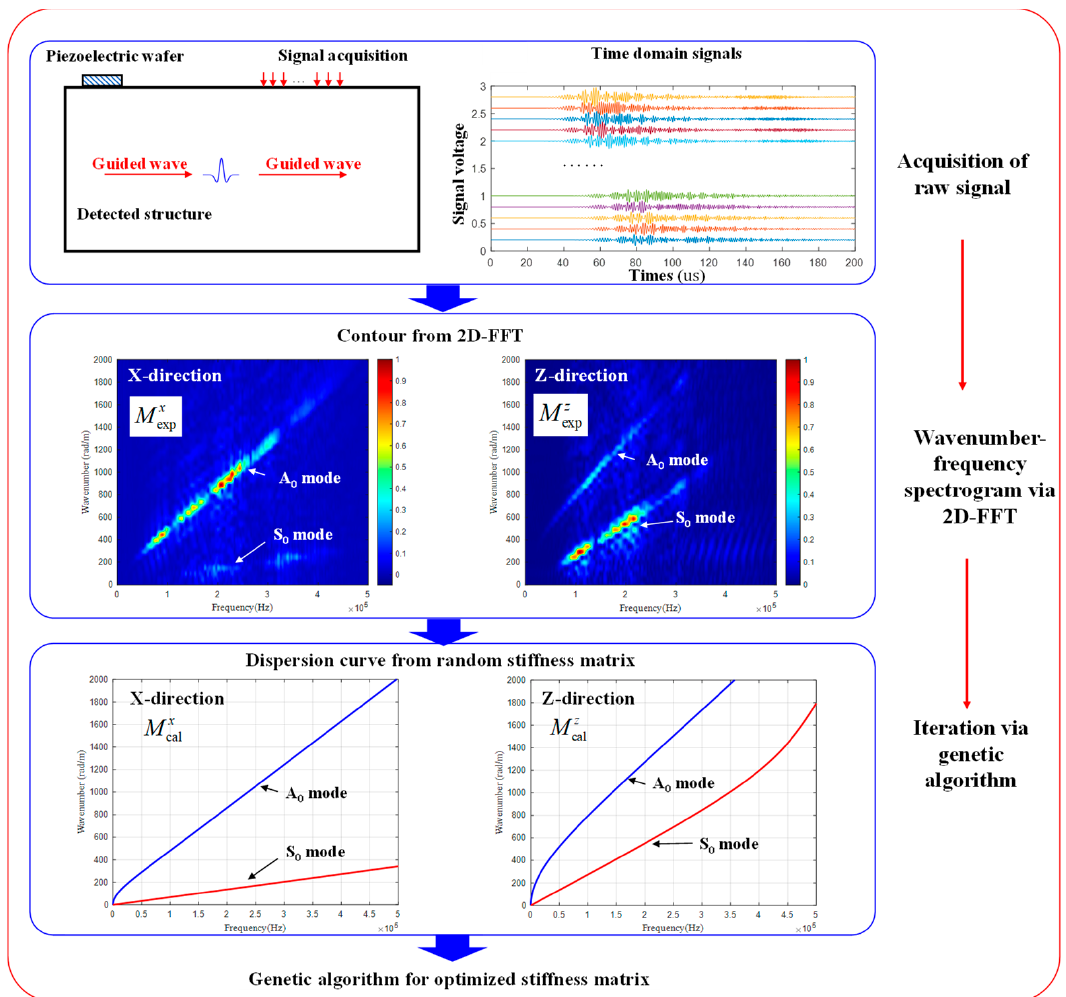
Figure 4. Flowchart of parameter reconstruction based on GA.